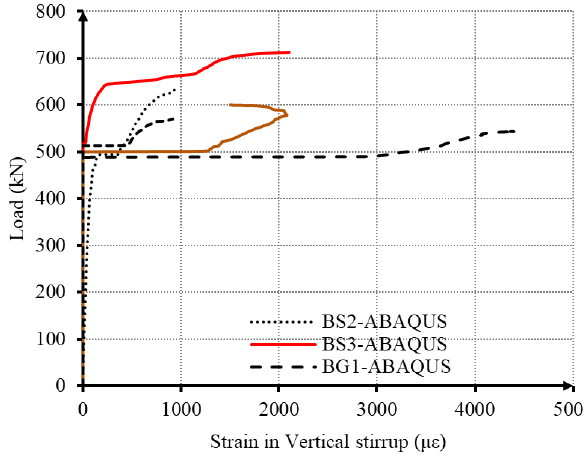
Figure 35: Strain curve of vertical web reinforcement for deep beams